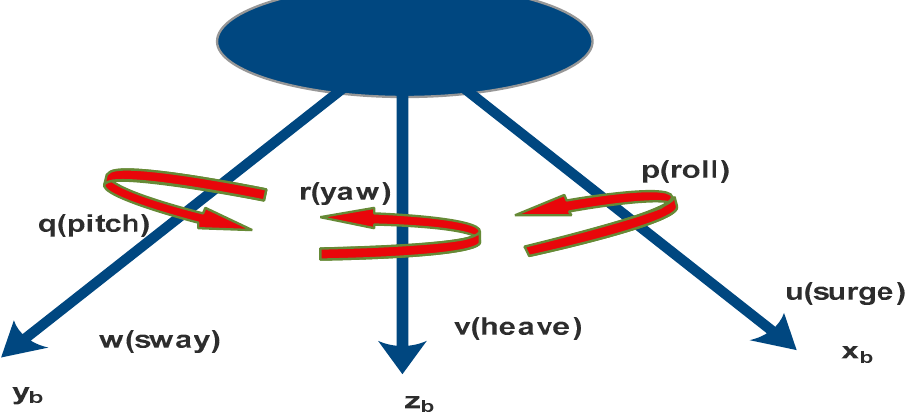
Figure 1. Motion parameters of the autonomous underwater vehicle.